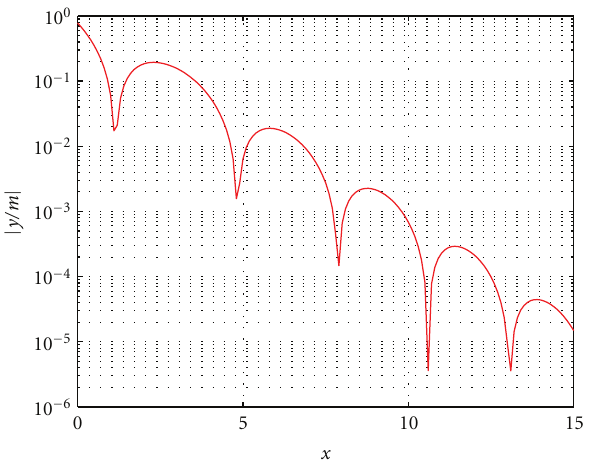
Figure 4: The spatial oscillation of the groove profile. Figure 5: The curvature of the groove